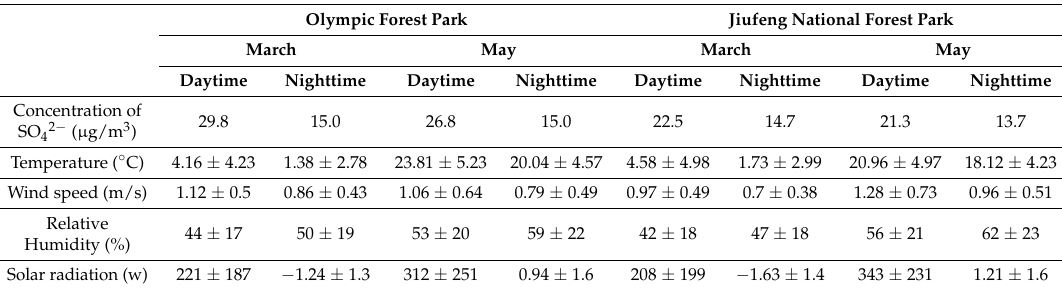
Table 1. Meteorological conditions at two sampling sites during investigation period (mean ± standard deviation).